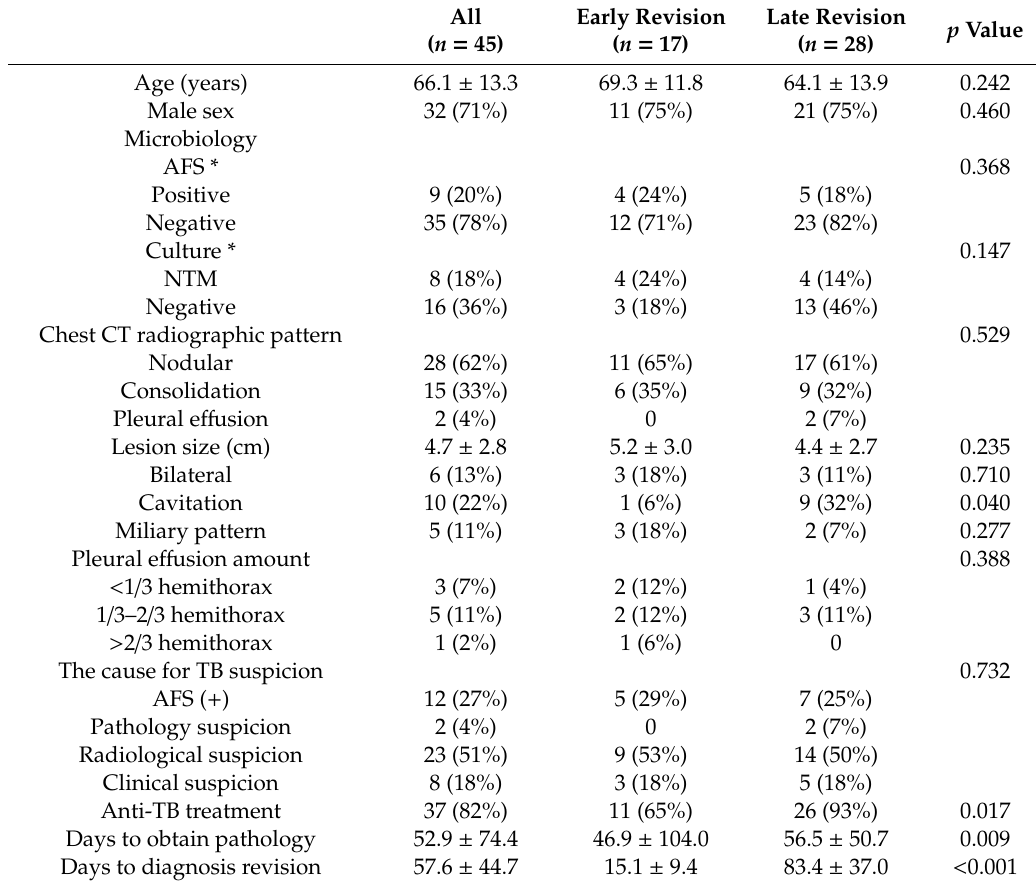
Table 1. The demographics of patients according to the time to revise the